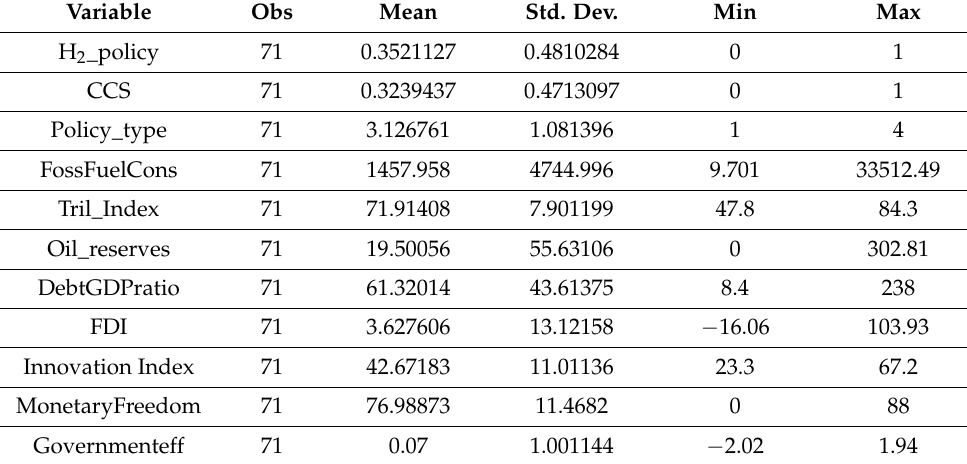
Table 3. Descriptive